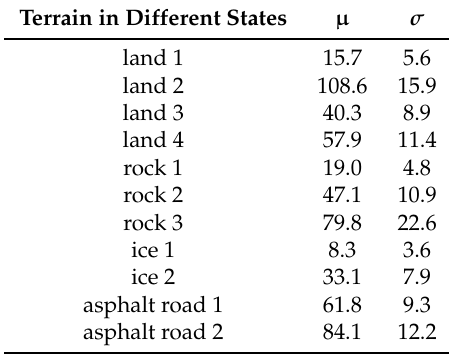
Table 2. Means and variances of surface structure characteristics.